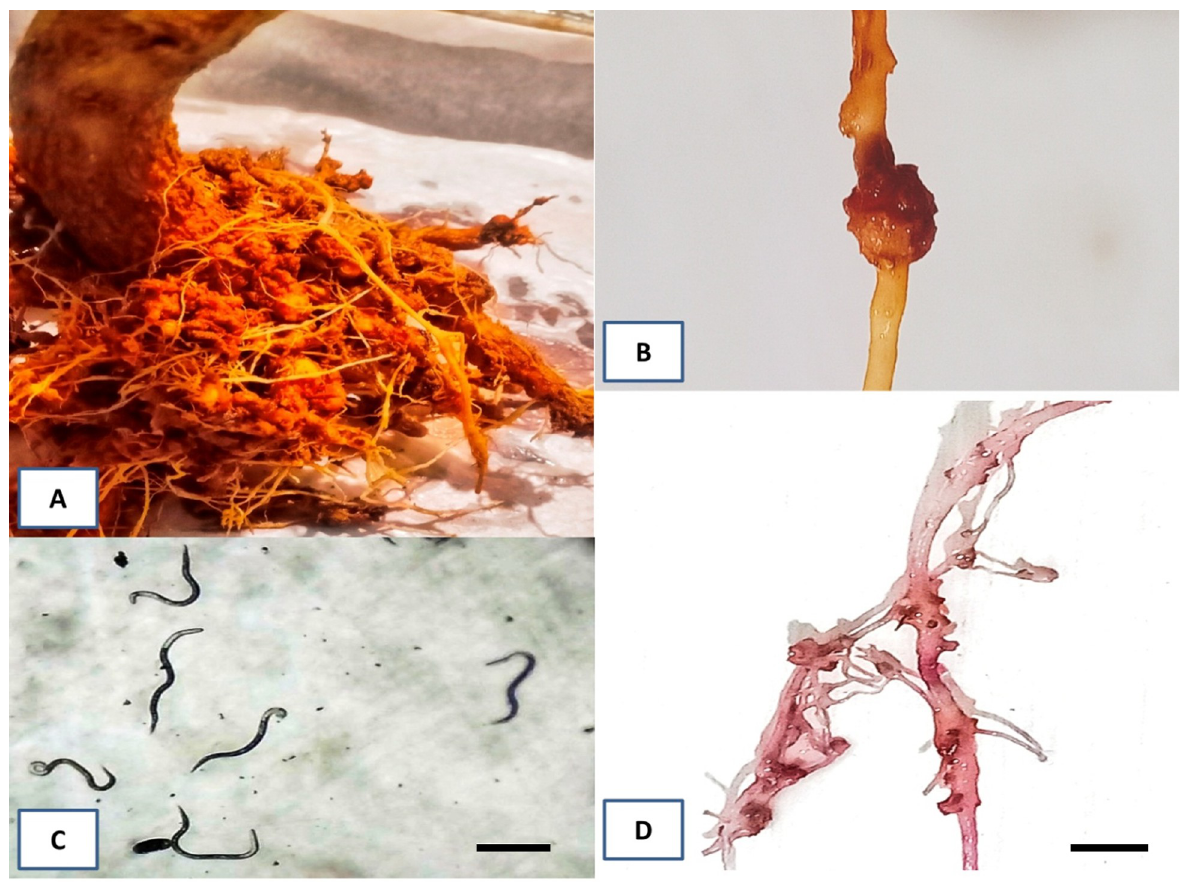
Fig 2. Representative pictures of disease symptoms caused by juveniles of the root-knot nematode M . incognita . (A) Large root galls or knots were formed throughout the root system of eggplants infected by M . incognita . (B) A closed up picture of a root gall. (C) Juveniles in J2 stage. Scale bar = 200 μ m. (D) Egg mass on infected roots. Scale bar = 10